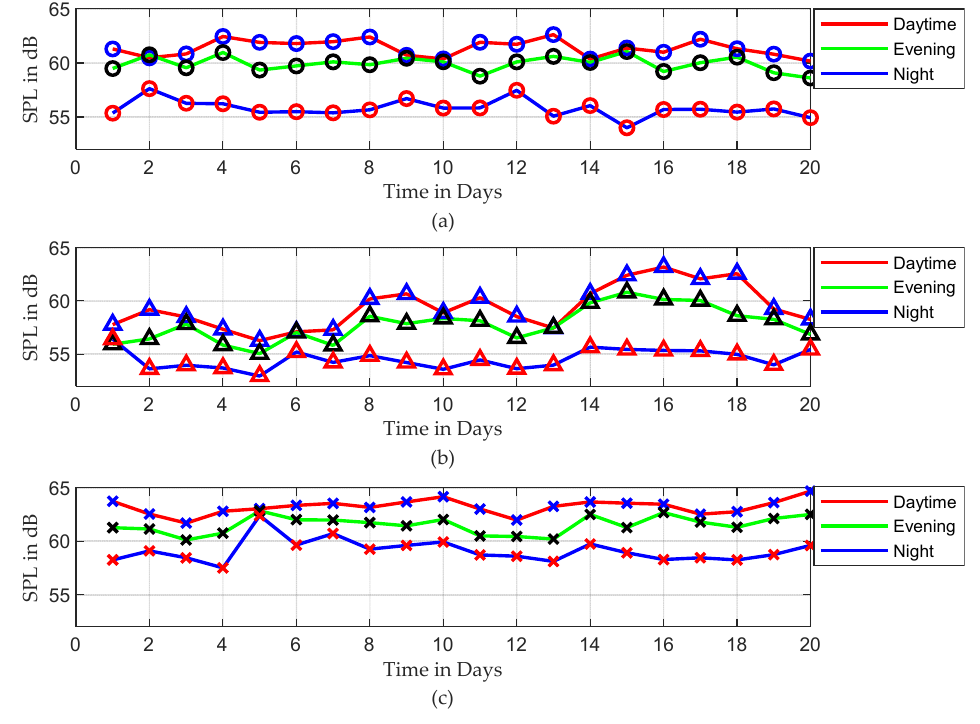
Figure 7. Average of SPLs among three periods over 20 days, the red, green, and blue curves represent the average of SPLs for daytime, evening, and night, respectively, ( a ) ICU1, ( b ) ICU2, and ( c ) ICU3.